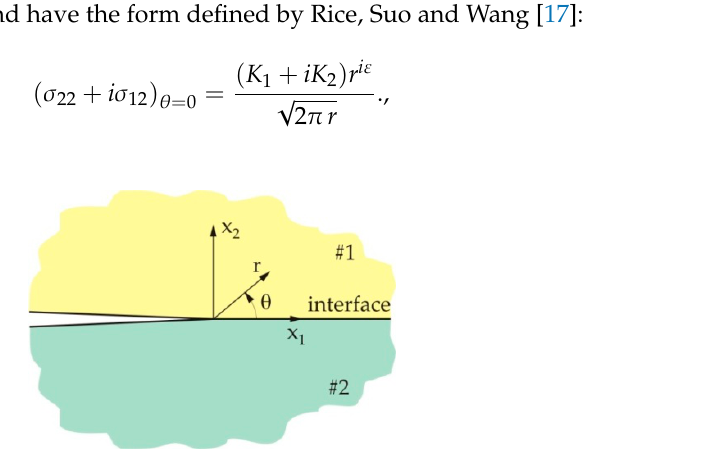
Figure 2. Geometry of a crack at the interface between the two dissimilar materials.